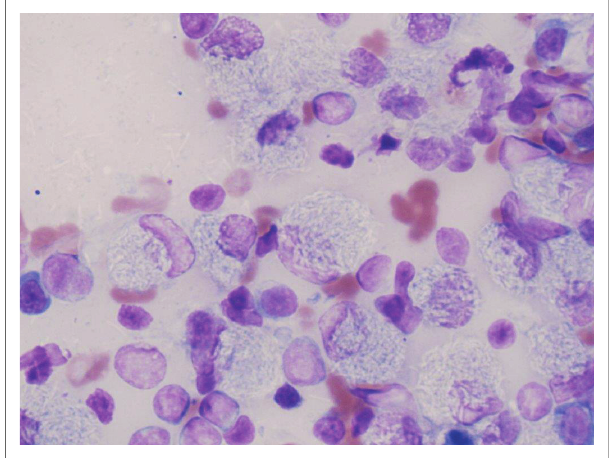
FIGURE 3: Wright-Giemsa stained mesenteric lymph node cytology (1000 x).